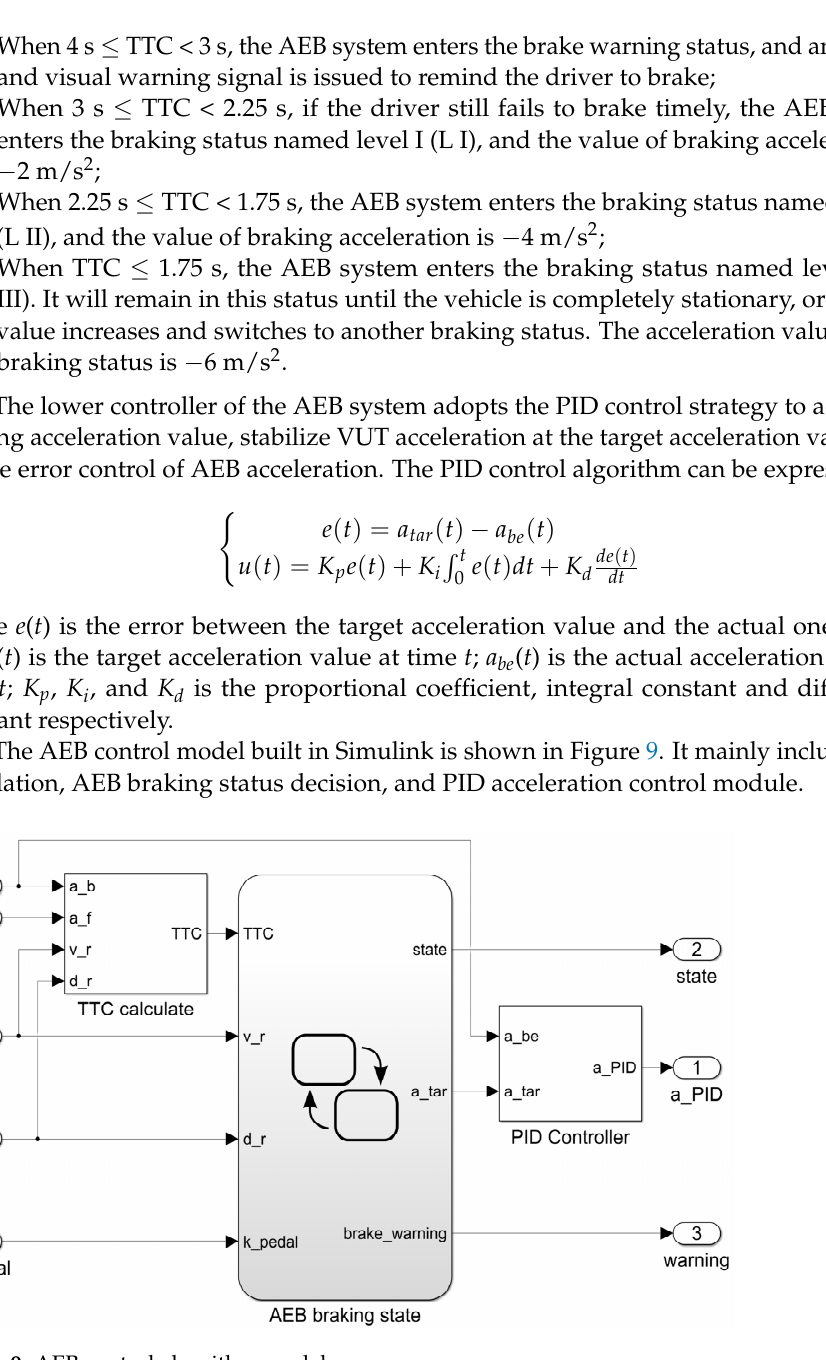
Figure 9. AEB control algorithm model.